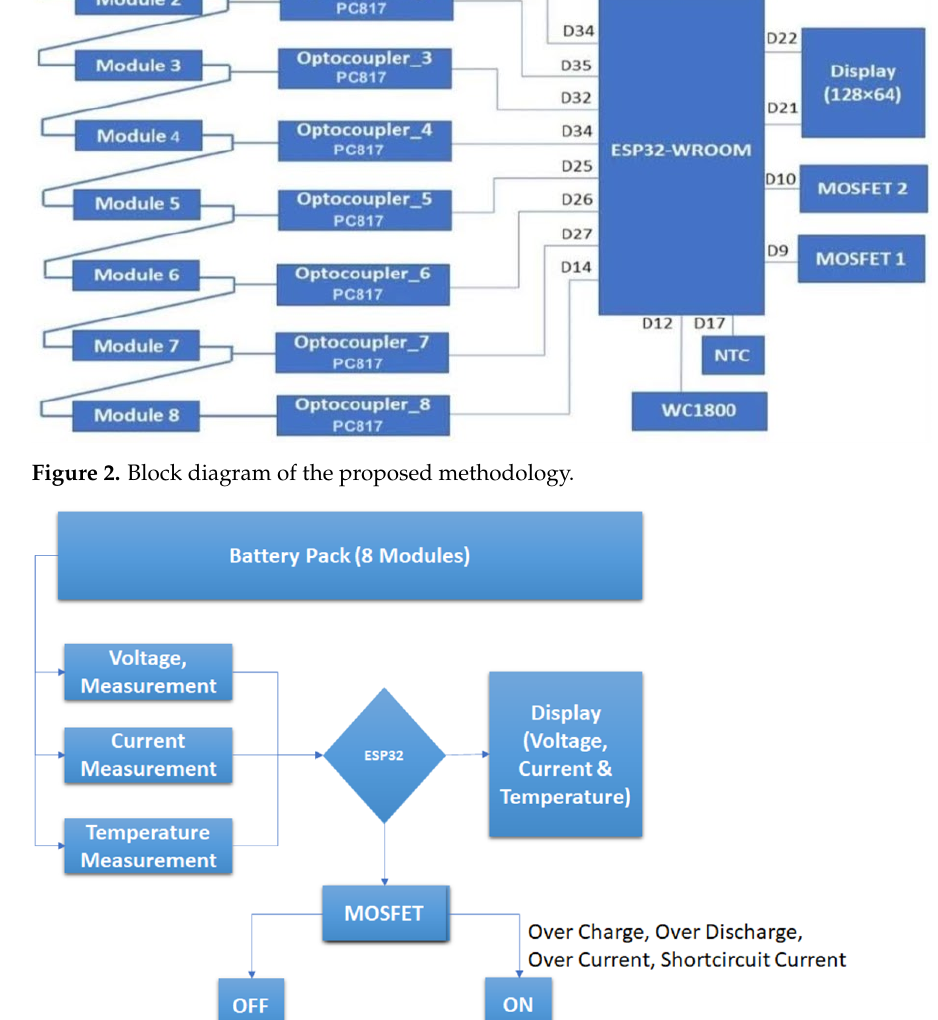
Figure 3. Flow chart for measuring voltage, current, and temperature of a battery using linear optocouplers.